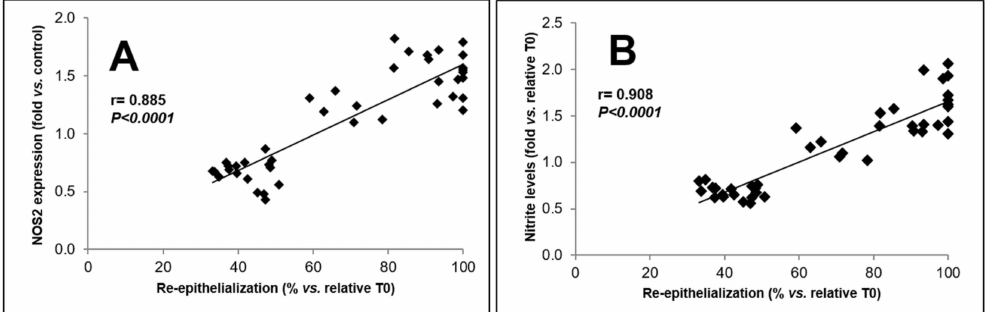
Figure 5. Analysis of correlation between NOS2 expression, nitrite levels, and wound closure rate. ( A ) Pearson’s test analysis of the correlation between NOS2 expression (fold vs. control) and wound closure rate expressed as % re-epithelialization vs. relative T0. ( B ) Pearson’s test analysis of correlation between nitrite levels (fold vs. relative T0) and wound closure rate expressed as % re-epithelialization vs. relative